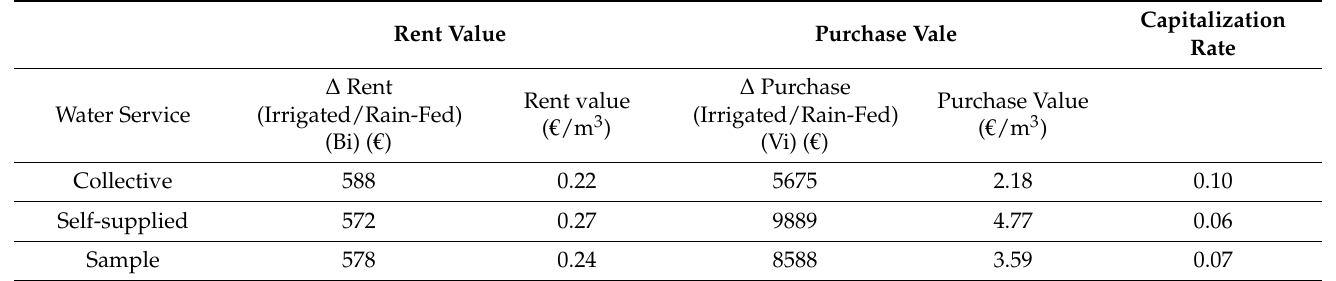
Table 9. Water resource monetary value estimation and capitalization rate. Rent Value Purchase Vale